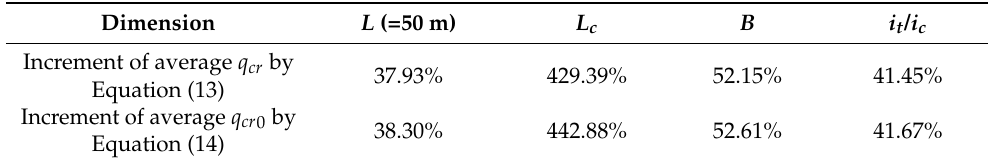
Table 1. Increment of the average buckling load over the considered dimensions for the pin-ended Vierendeel truss arches considering GI pci with respect to that ignoring GI pci